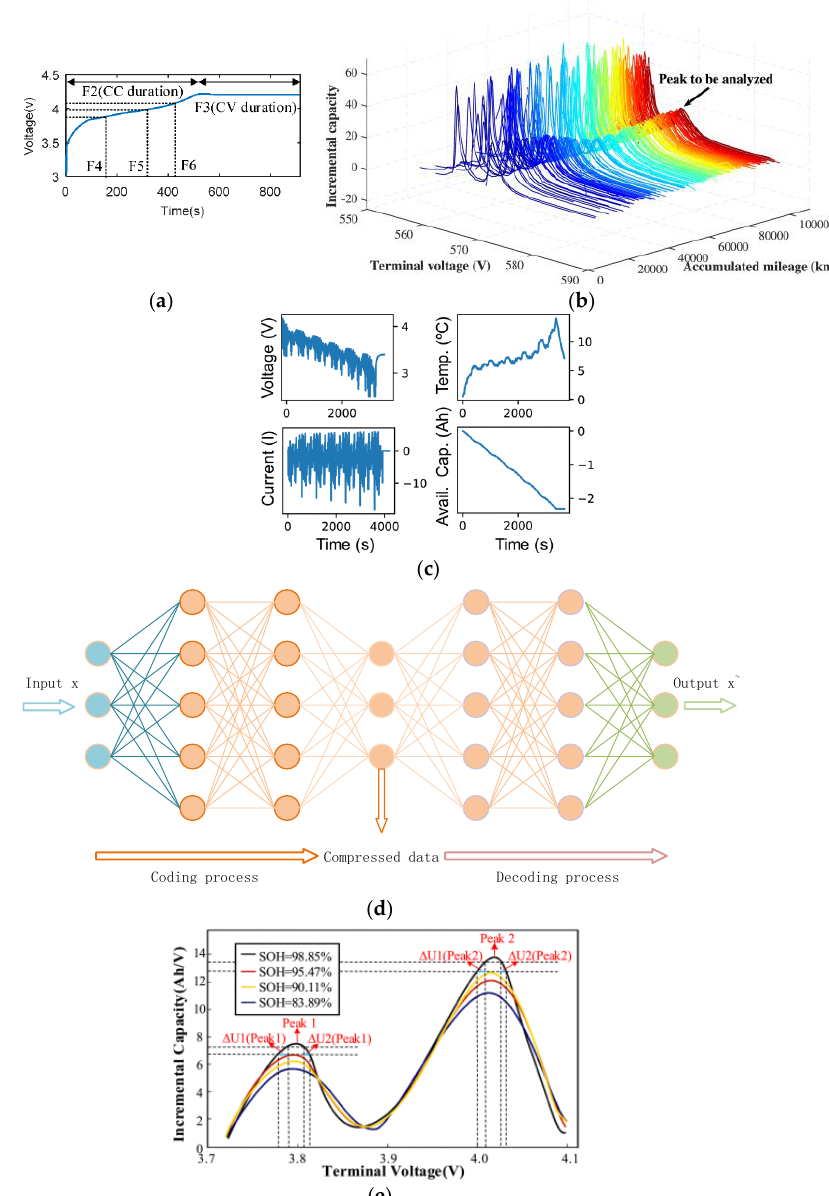
Figure 4. ( a ) Feature selection of charging voltage curve; ( b ) Comparison of IC curves under different cycles; ( c ) Basic charging and discharging characteristics of lithium-ion batteries; ( d ) Basic structure of AutoEncoder; ( e ) Feature Selection of IC Curves